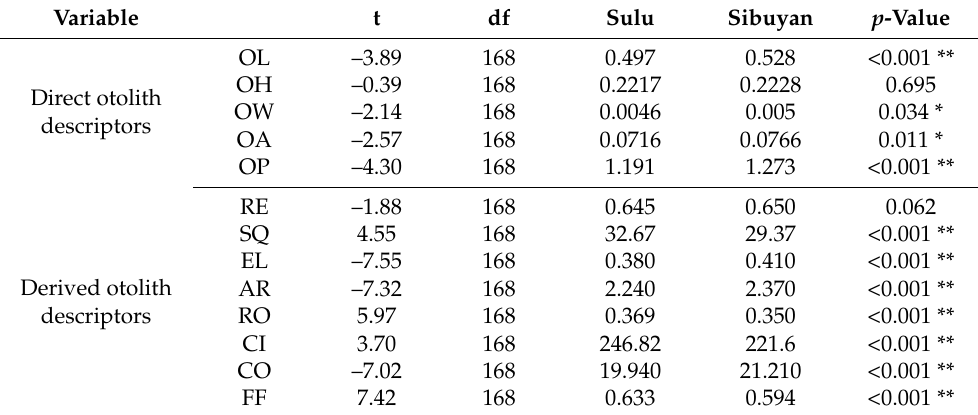
Table 4. Summary of independent sample t-tests on otolith descriptors of D. kurroides from Sulu and Sibuyan seas.